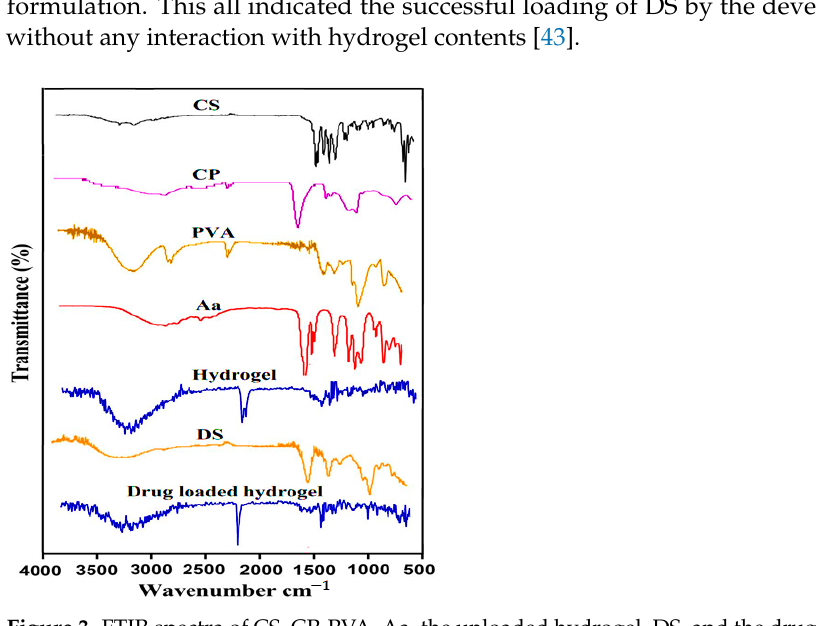
Figure 3. FTIR spectra of CS, CP, PVA, Aa, the unloaded hydrogel, DS, and the drug-loaded hydro ‐ gel.